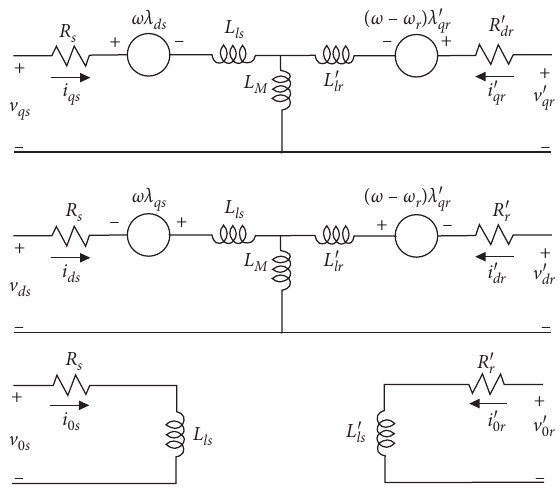
Figure 6: Arbitrary reference-frame equivalent circuits for a 3-phase, symmetrical induction machine.